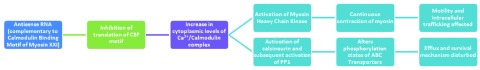
Flow chart of strategy I.CBF, Calmodulin Binding Motif; PP1, protein phosphatase 1; ABC transporters, ATP-binding cassette transporters.